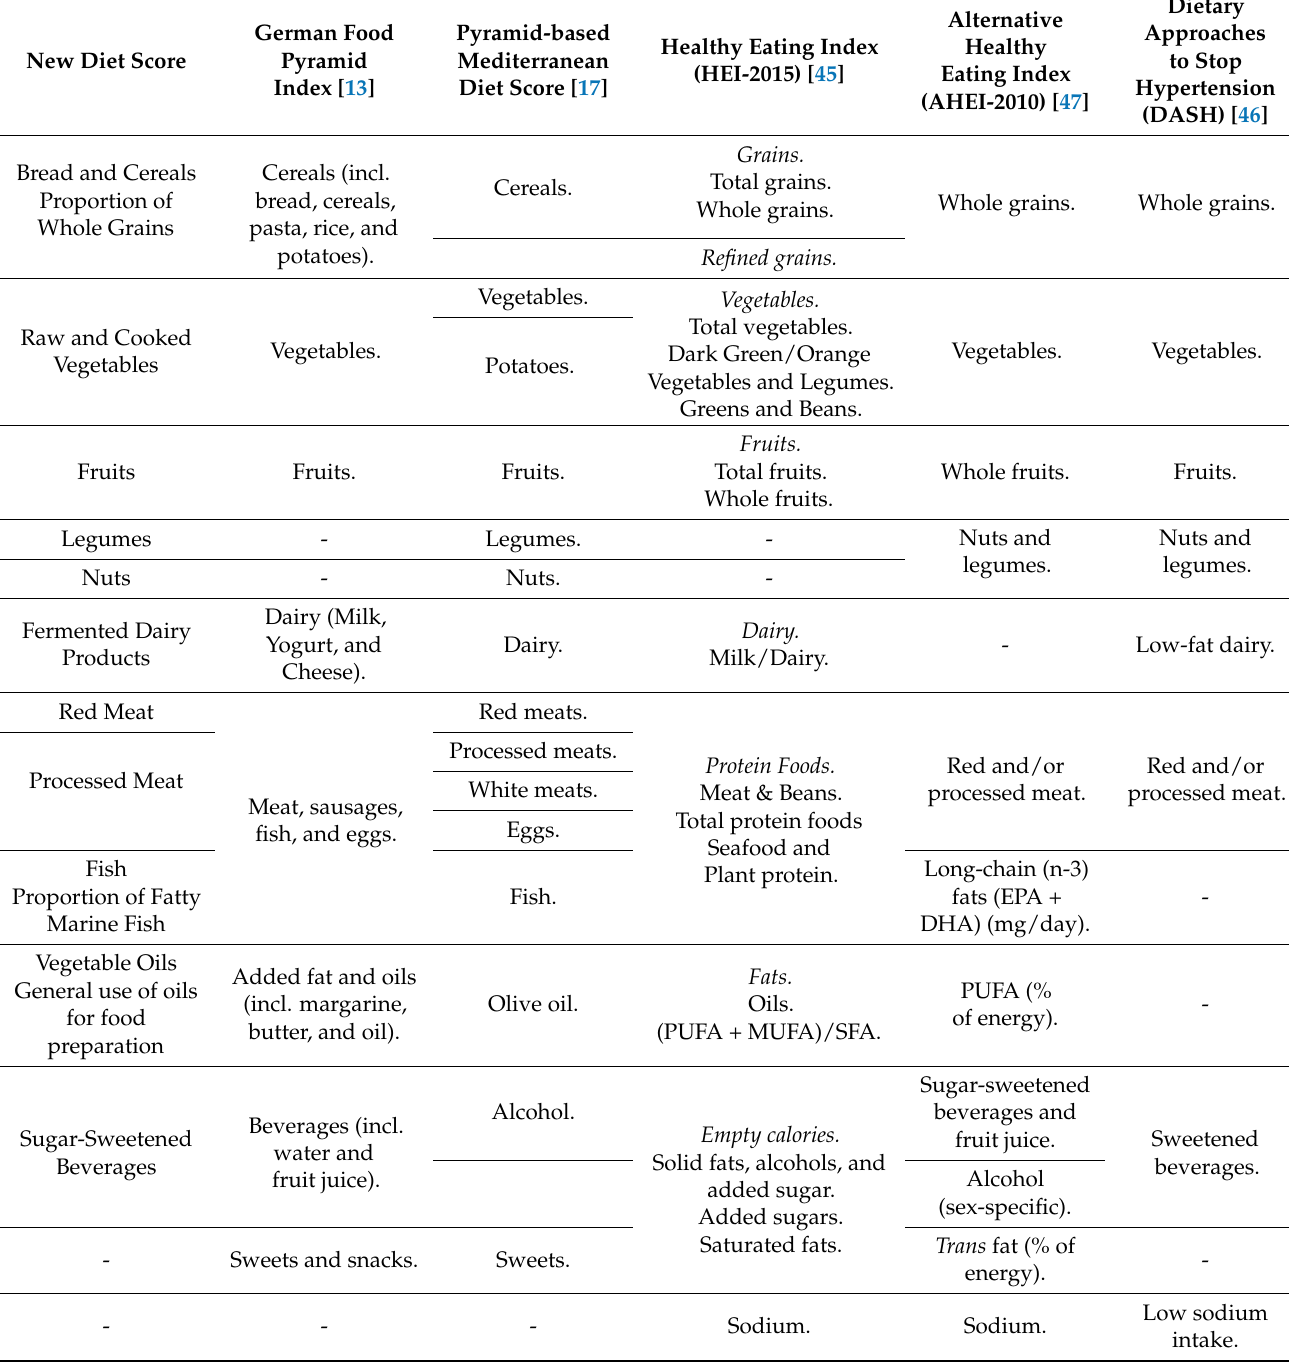
Table 3. Comparison of food groups included in the new diet score for healthy eating with so far established diet